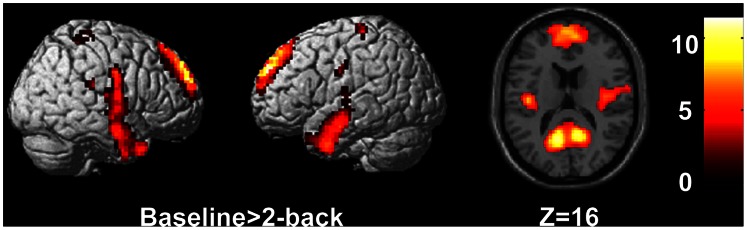
Regions with significant activations at rest state compared with 2-back task (p<0.05, FWE corrected).